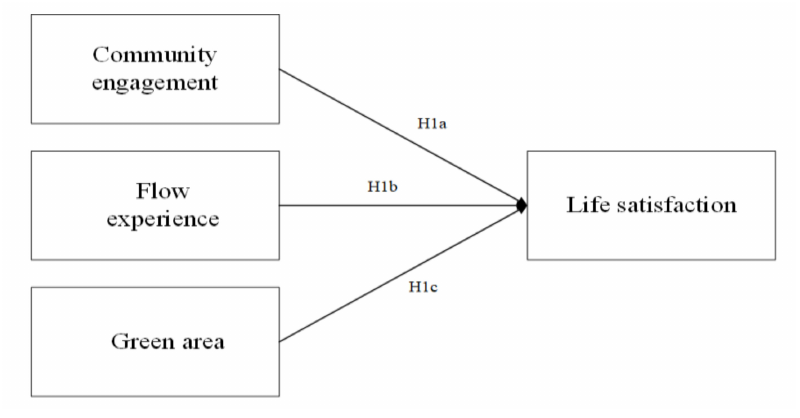
Figure 1. The basic model. H1c : Green area has a positive influence on life satisfaction (confirmative